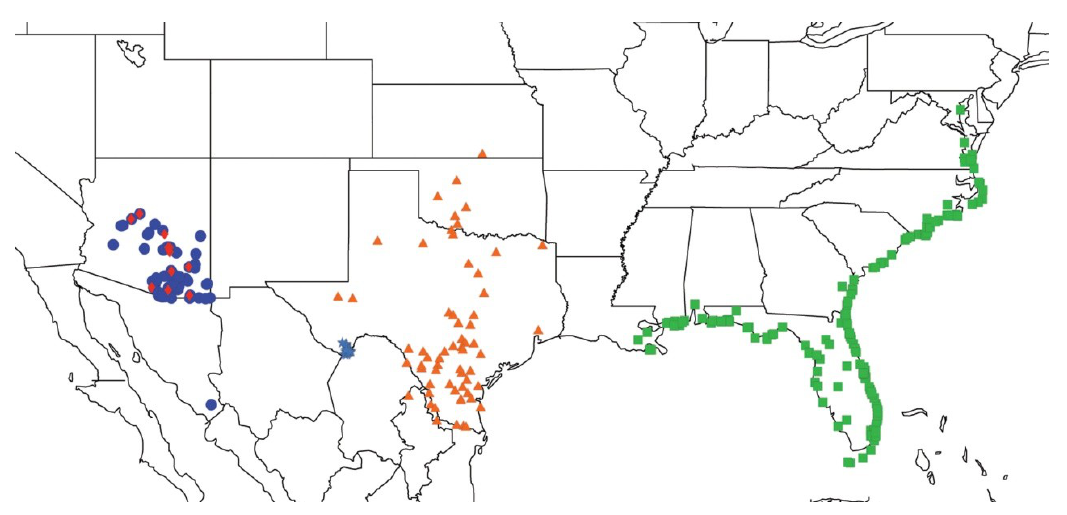
Figure 4. Distribution of Dicerprocta swalei swalei (blue circles), D. swalei castanea (red diamonds), D. canescens (light blue stars), D. azteca (orange triangles) and D. viridifascia (green